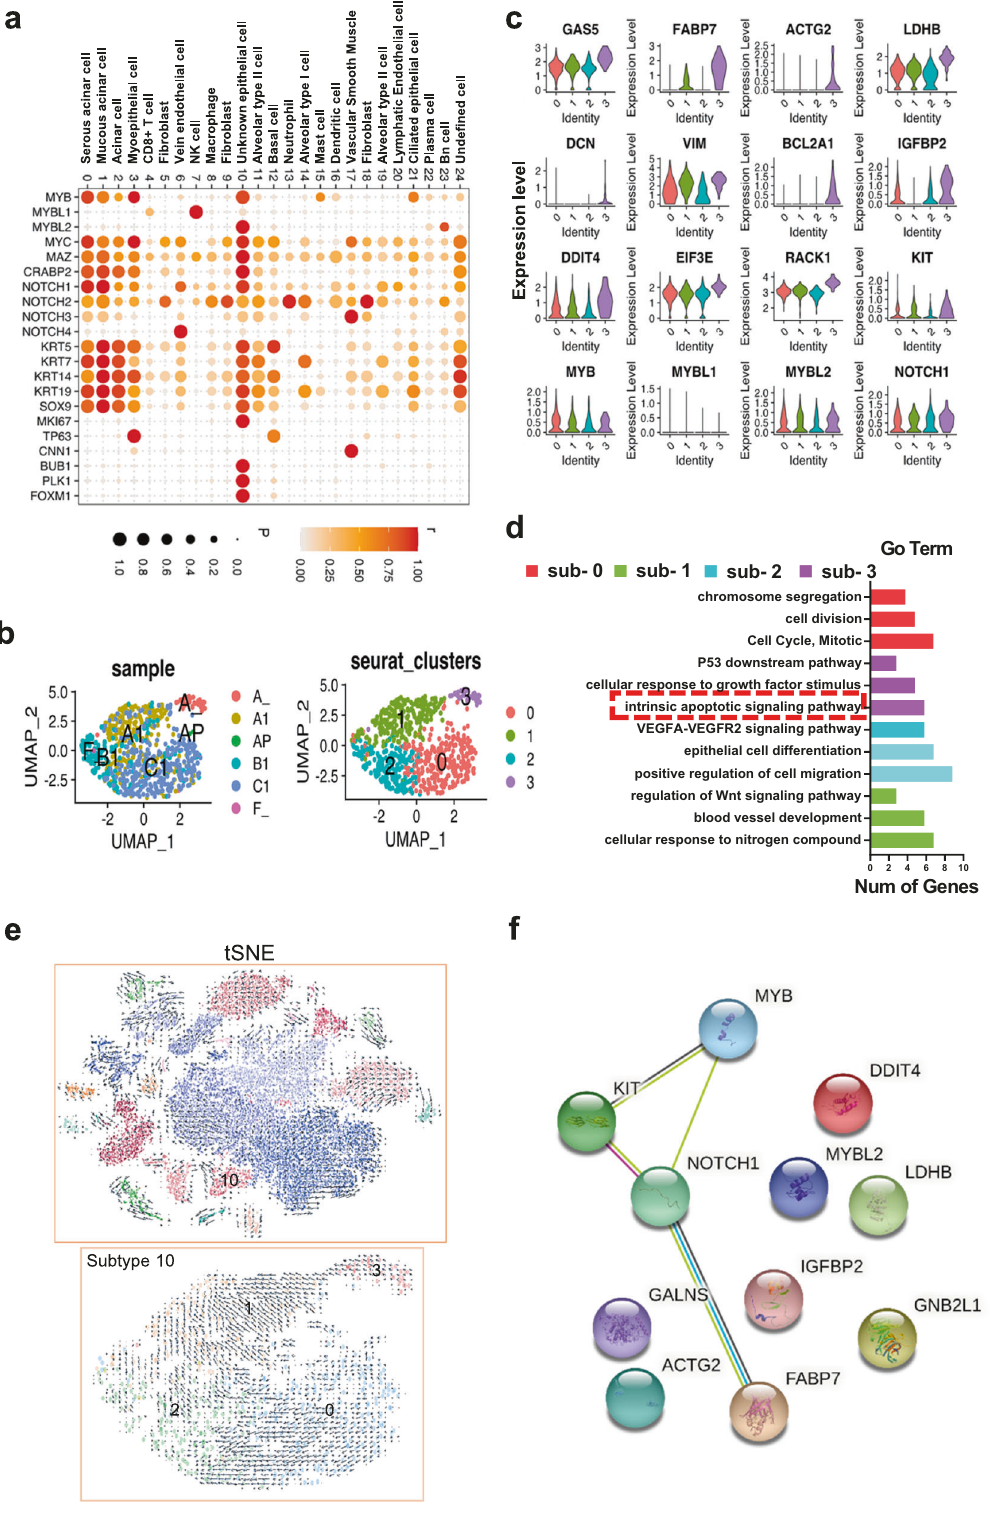
Fig. 2 Characterizing metastasis-associated clusters or cancer stem cells. a The dot plot shows marker genes likely related to SACC stemness and metastasis, as reported in the literature, that were enriched predominantly in cluster 10. b The t-SNE visualization of novel subtypes in cluster 10 shows the distribution in samples (left) and four novel subsets (right). c Violin plots of signature genes, including the top 12 marker genes, as well as MYB, MYBL1, MYBL2 , and NOTCH1 in all the subtypes from cluster 10. d GO analysis of all subtypes; subtype 3, which is enriched in genes related to the antiapoptotic pathway, is highlighted. e RNA velocity analysis of all cells and all subtypes by Velocyto soft. The arrow in the plot indicates the direction of differentiation, and the length of the arrow indicates the speed of differentiation (a longer arrow indicates a faster speed). f PPI analysis showing the known interactions, MYB/MYBL2 , NOTCH1 , and the top eight marker